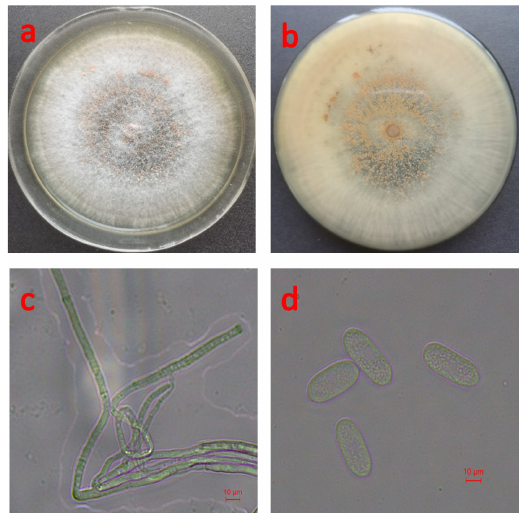
Figure 3. Morphological characteristics of strain CXCDF-3: ( a ) front side of strain CXCDF-3 grown on PDA plate; ( b ): back side of strain CXCDF-3 grown on PDA plate; ( c ) mycelium of strain CXCDF-3; ( d ) conidium of strain